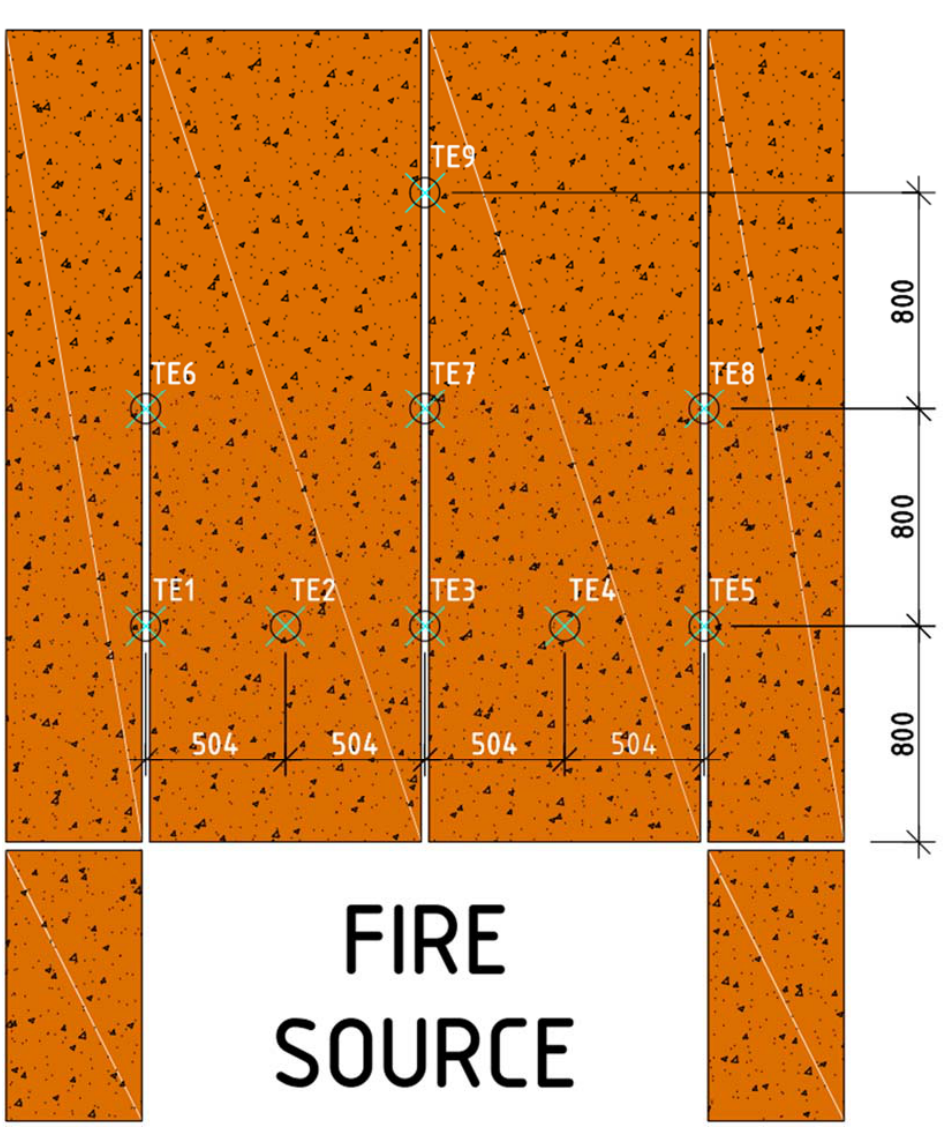
Figure 5. Location of thermocouples on the large-scale facade model—front view.